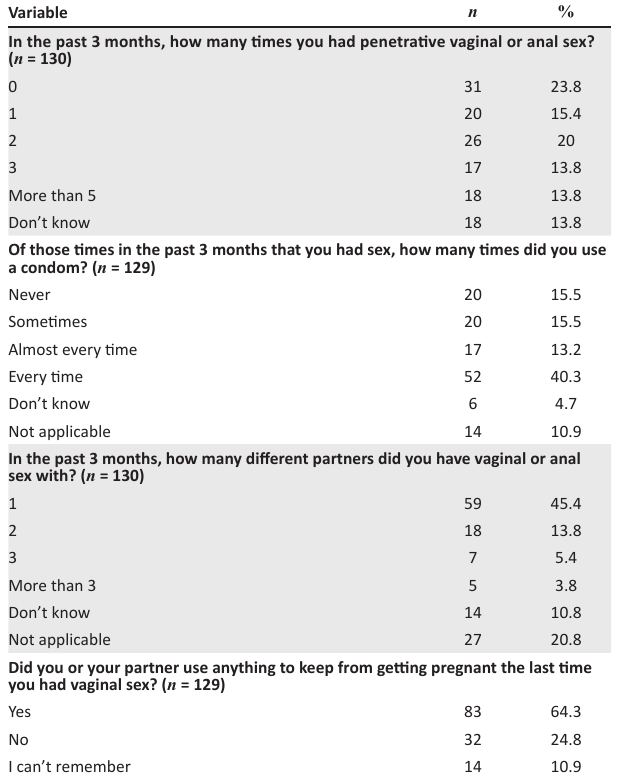
TABLE 4: Sexual risk behaviours.